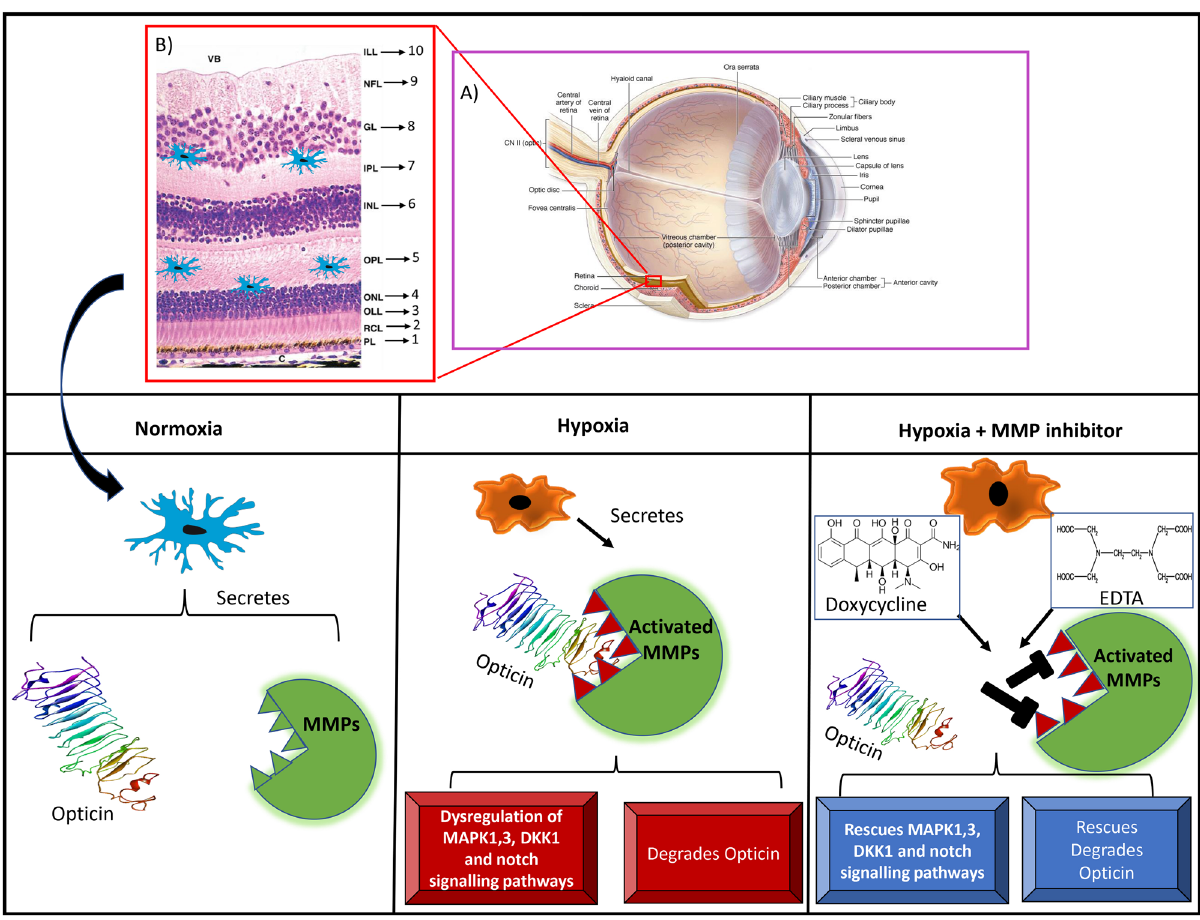
Figure 7. A schematic summary of the role of MMP mediated opticin degradation in microglia under hypoxic stress and in retinopathy of prematurity. Modified and adapted from A: https:// quizl et. com/ 23201 2123/ anato my- of- the- inter nal- eye- diagr am 39 B: Jacob Cook (2016)